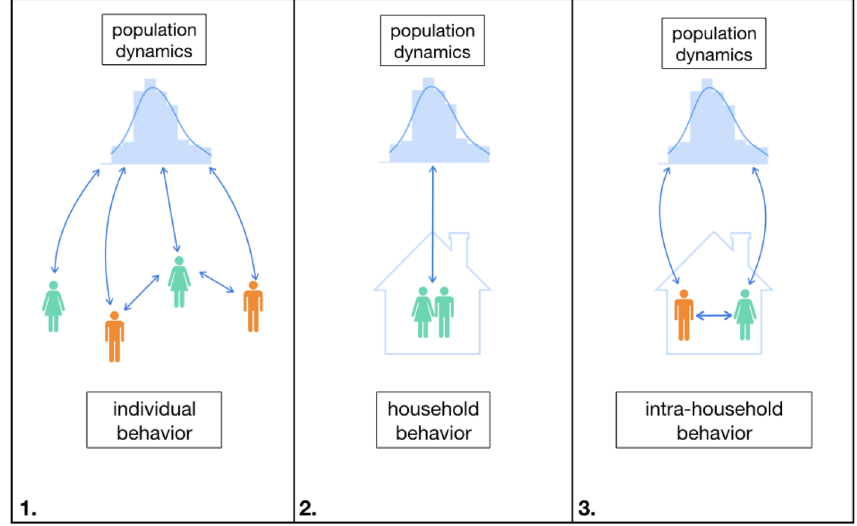
Figure 1. Differences between the individual, unitary and intra-household frameworks. Arrows indicate interaction, the colors of the agents represent some set of preferences (i.e. “green” is different than “orange”.) Panel 1 shows an individual-based ABM of social norms in which agents have different preferences, interact with one another and with social norms, but do not interact as household members. Panel 2 shows a unitary household-based ABM with a single set of preferences and no intra-household interaction. Panel 3 shows our ABM with intra-household decision-making between heterogeneous